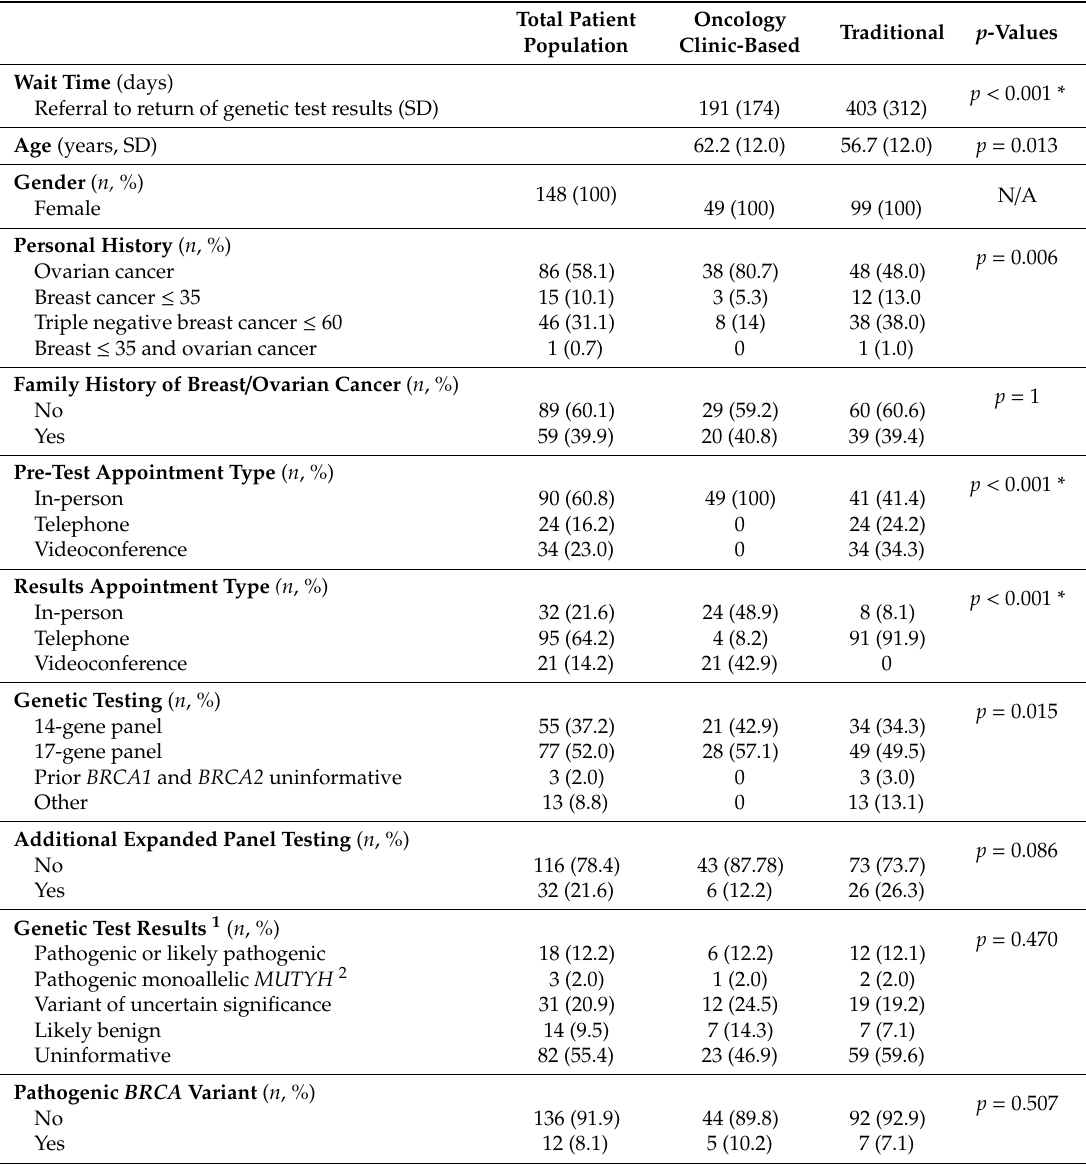
Table 1. Patient Demographics, Wait Times, Genetic Testing.